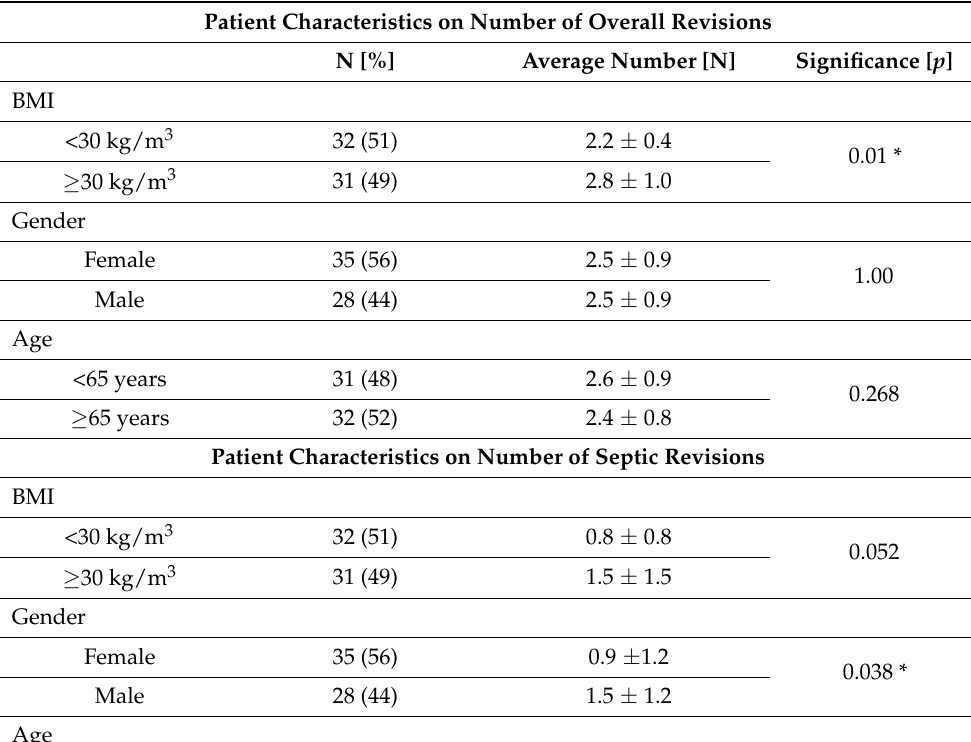
Table 4. Impact of demographic parameters on average number of overall and especially septic